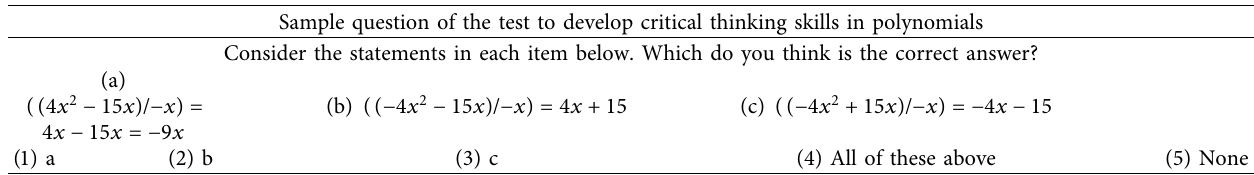
Table 3: Sample test question.